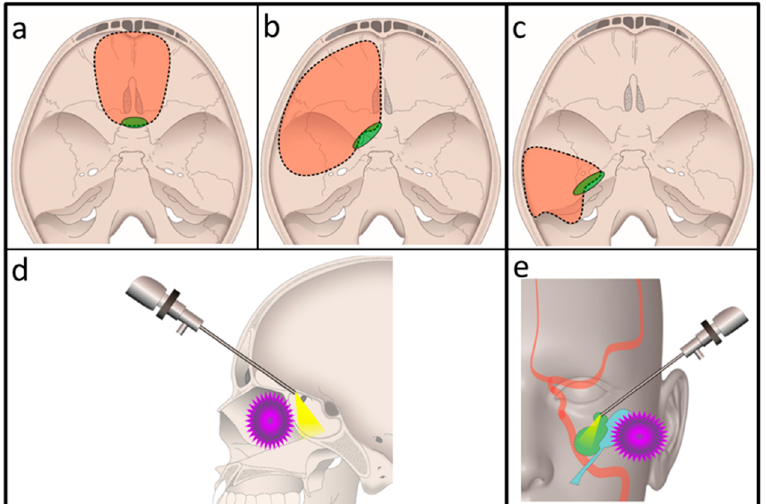
Figure 3. Schematic diagram of skull base site treated with craniofacial resection. ( a ) Anterior craniofacial resection. ( b ) Anterolateral craniofacial resection. ( c ) Temporal bone resection. Red region enclosed by dotted line: skull base resection region. Green ellipses: the points at which an endoscope was used. ( d , e ) Transcranial endoscope use. ( d ) Anterior and anterolateral CFR. An endoscope is inserted into the sphenoid sinus through the opening created by the transcranial sphenoidotomy. The anterior wall and floor of the sphenoid sinus are transected under endoscopic visualization. Purple: tumor. ( e ) Temporal bone resection. The medial segment of the temporal bone is transected under direct visualization of the important anatomical structures using an endoscope. Red: internal carotid artery. Green: inner ear. Sky blue: middle ear and eustachian tube. Purple: tumor CFR, craniofacial